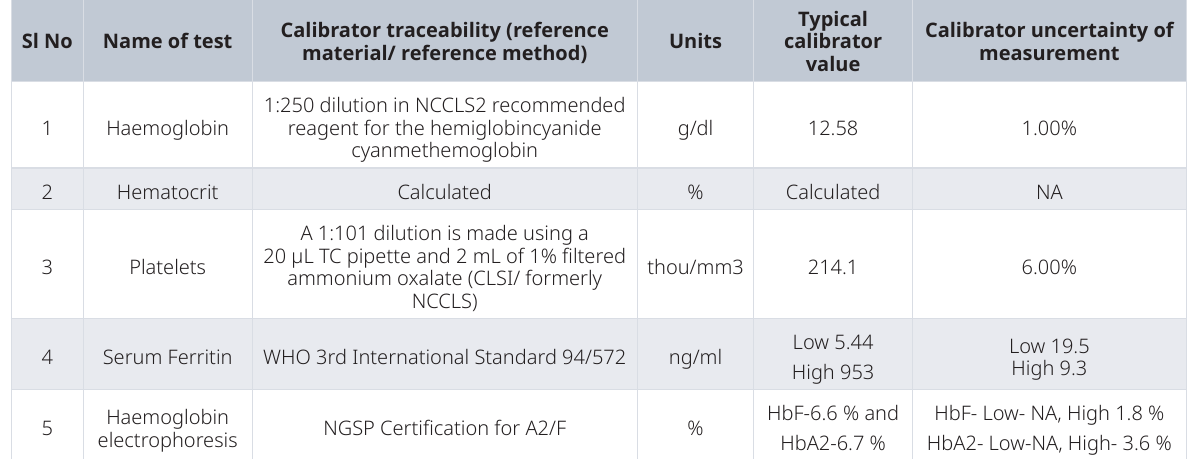
Table 1. Traceability of